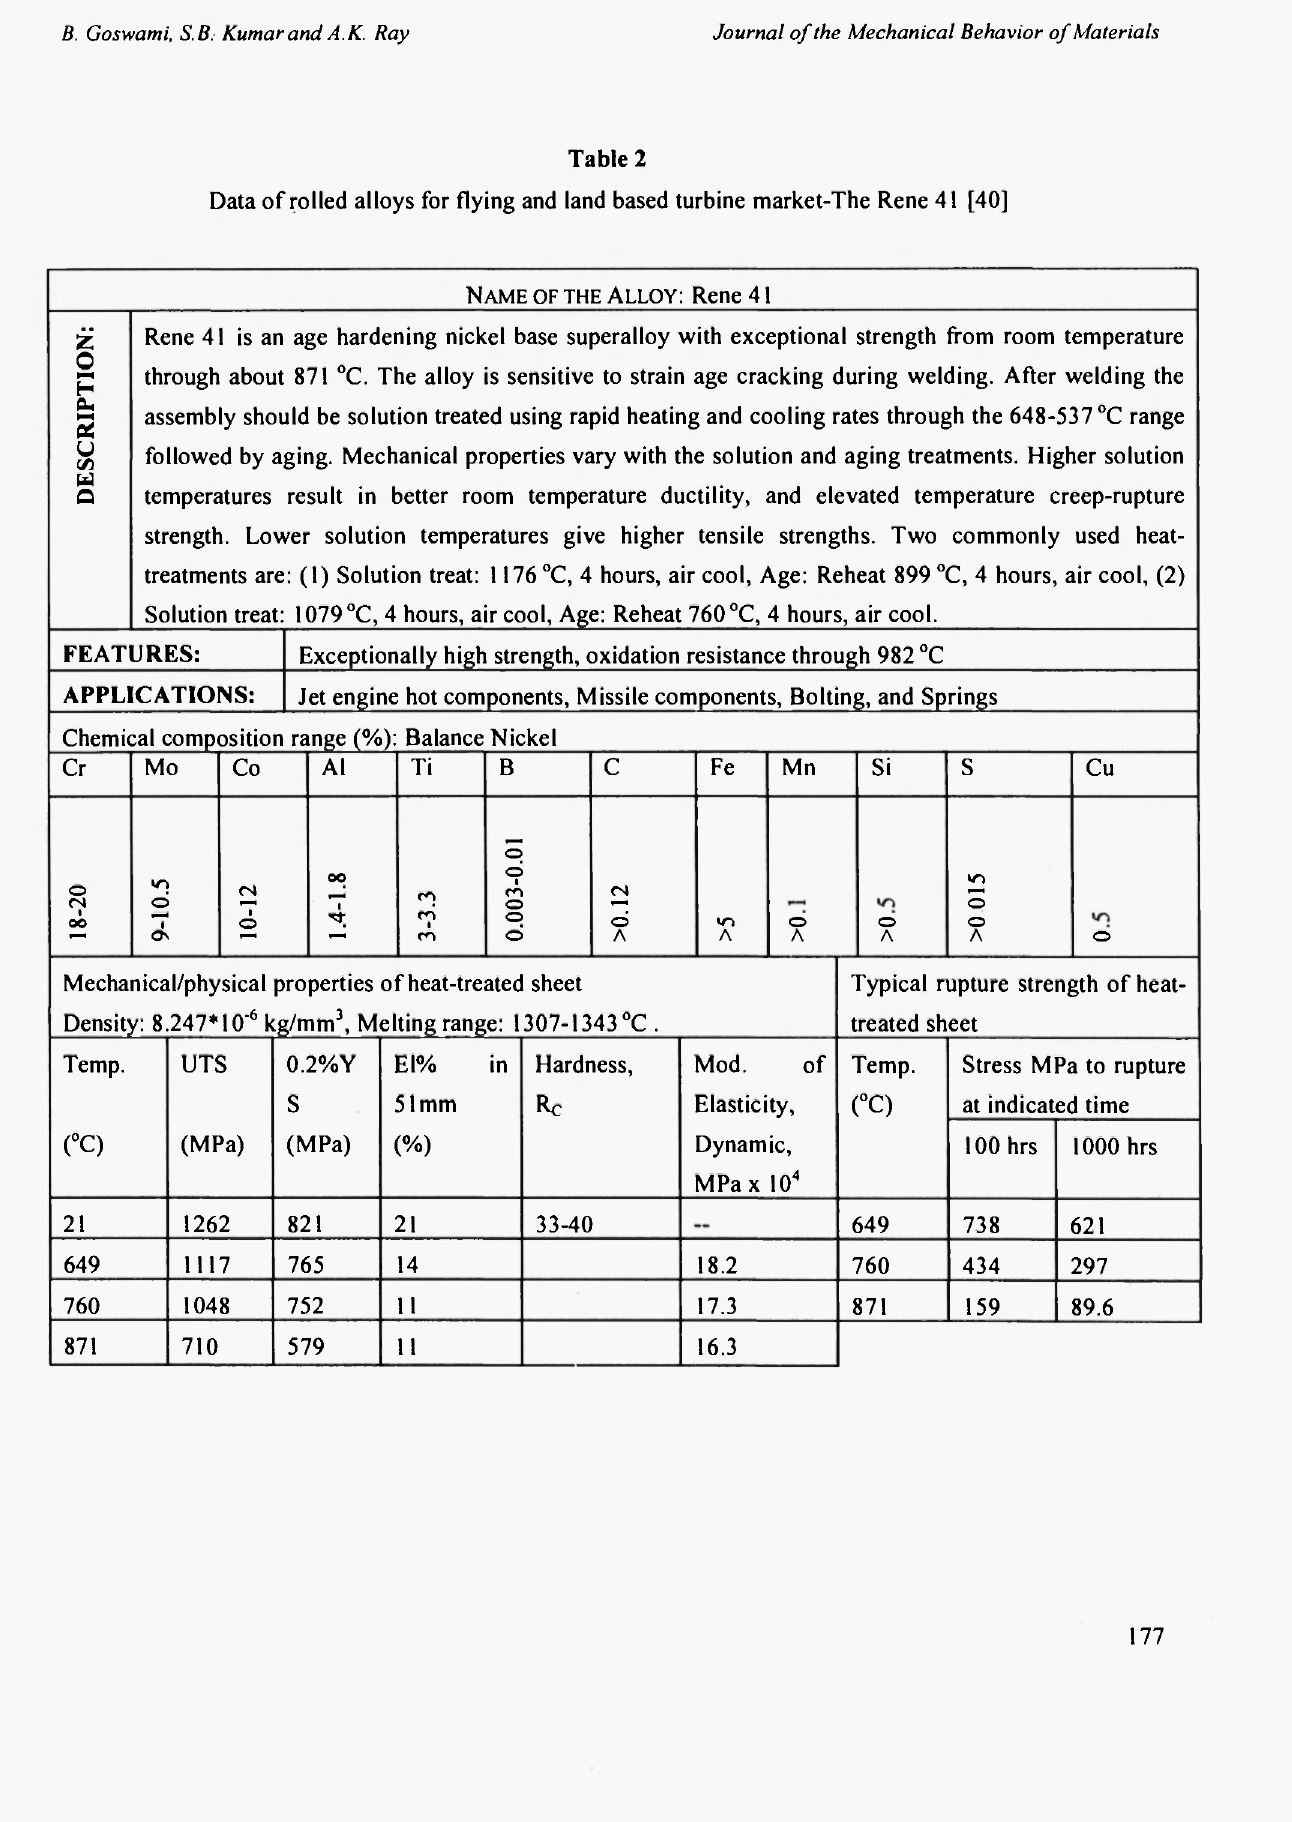
Data of rolled alloys for flying and land based turbine market-The Rene 41 [40]